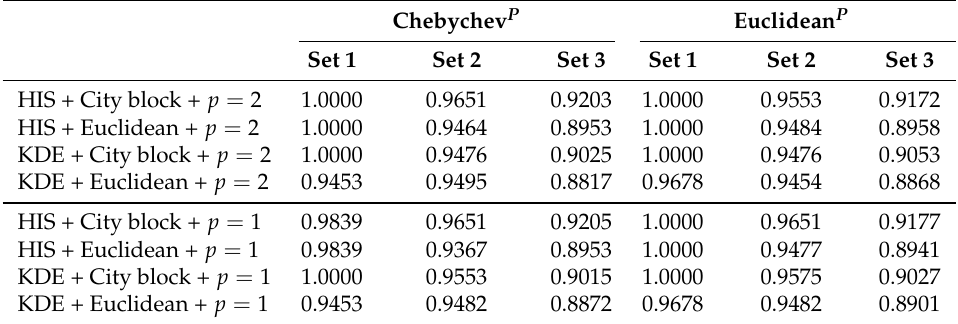
Table 1. Comparing (HIS + City block) against the other three options. The experiment is repeated for four varying choices of metric for affinity